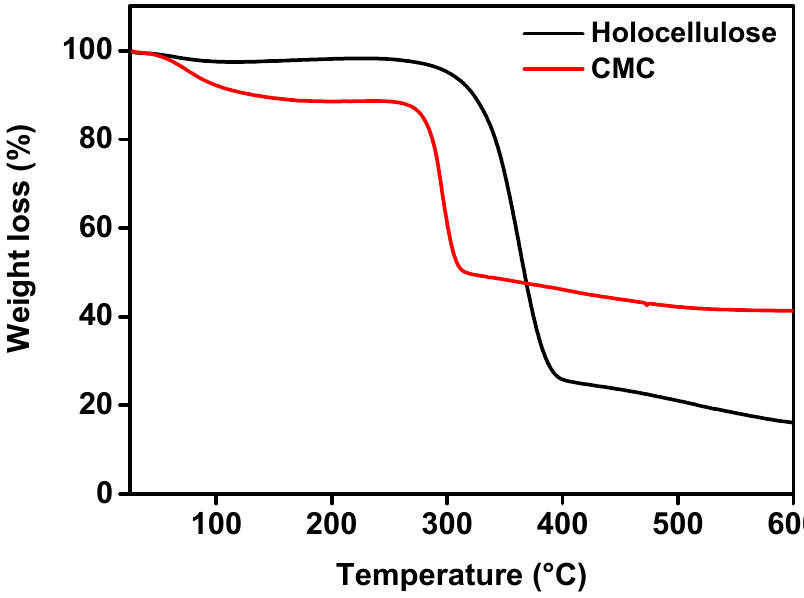
Figure 8. TGA curves of holocellulose and synthesized CMC (with degree of substitute 1.83).